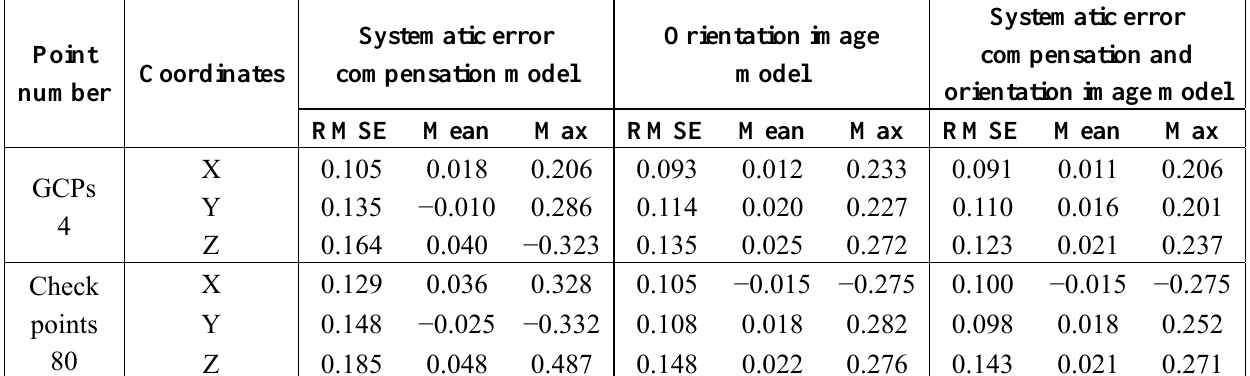
Table 2. Error statistics of bundle adjustment of Pingyao test field (Unit: m).